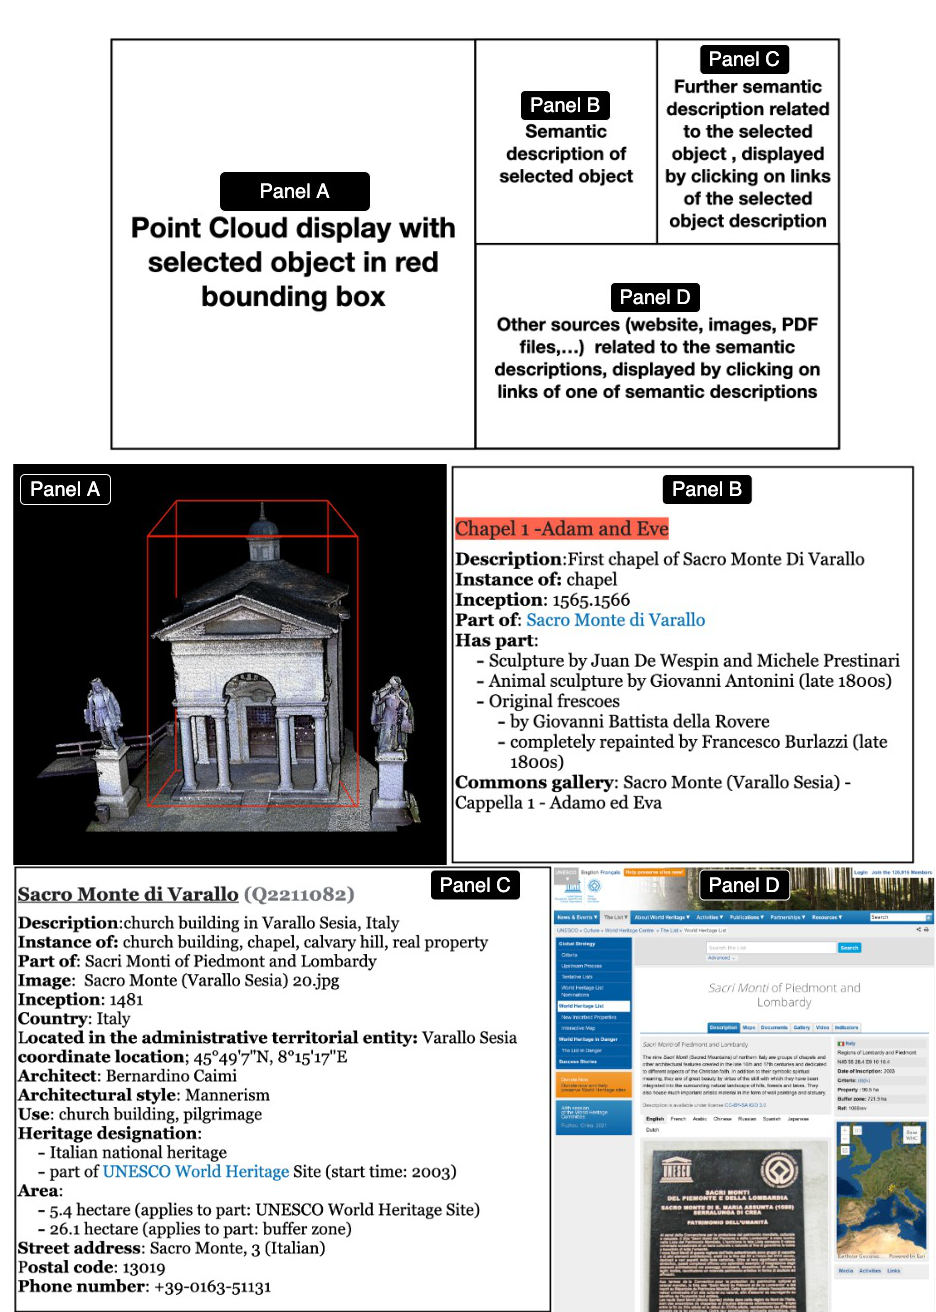
Figure 3. Explanation of interface made to present information and knowledge related to cultural heritage